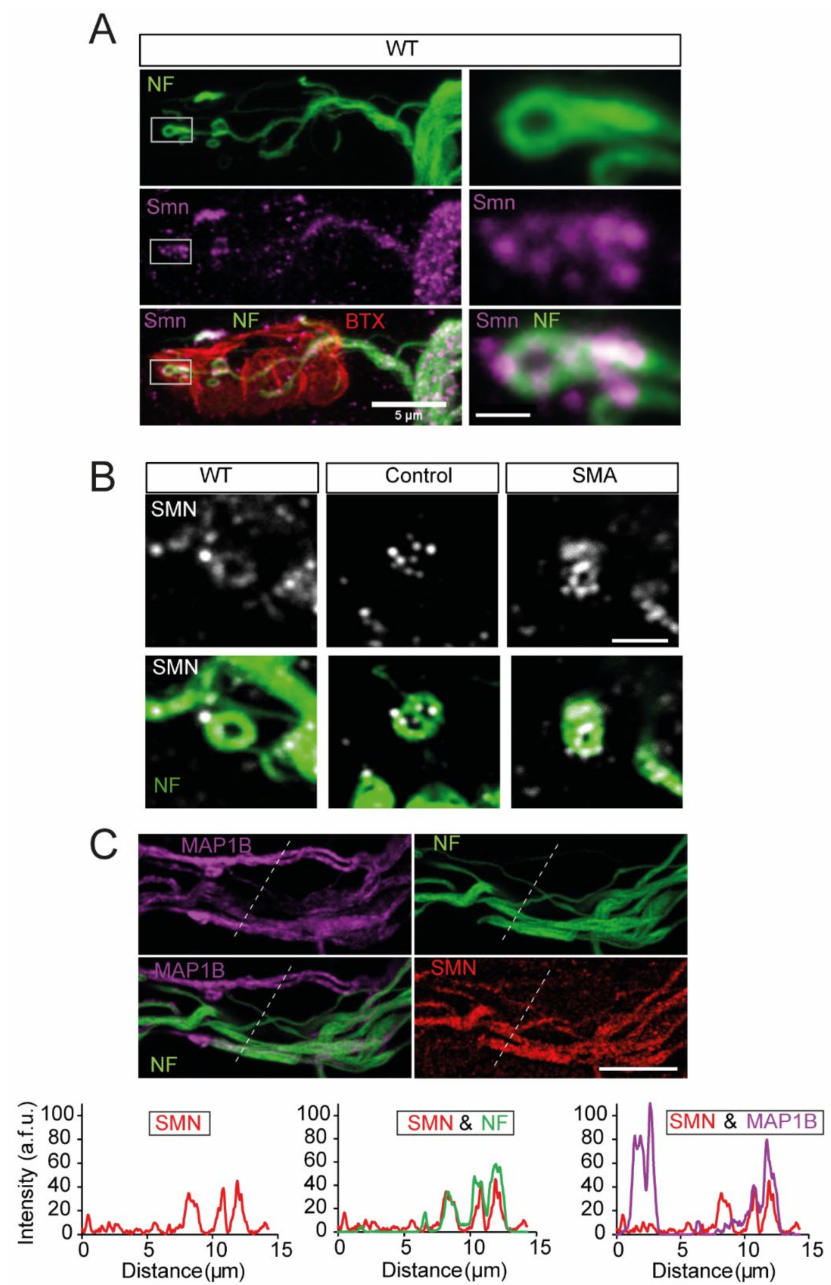
Figure 7. SMN granules co-localize with NFs in presynaptic motor terminals and axons. ( A ). Representative example showing that SMN granules (magenta) follow the NF (green) path, from the motor nerve to the distal part of the intraterminal branches, in a TVA muscle from a wild-type mouse. The endplate was labeled with BTX (red). On the right panels, the delimited regions are shown magnified. Scale bars: 5 µ m and 750 nm, respectively. ( B ). Details of SMN granules (grey), following NFs intraterminal structures (green) in wild-type and SMN ∆ 7 (control and SMA) mice. Scale bar: 2 µ m. ( C ). SMN granules show a greater degree of coincidence with the NFs than with MAP1B. Example of a band of axons from a Taiwanese control mouse labeled for MAP1B (magenta), NFs (green), and SMN (red). Note the heterogeneity of the axons, in terms of their immunoreactivity for each of these proteins. Scale bar: 10 µ m. The graphs display the intensity profiles through the lines in the images. Note the better coincidence of SMN (red trace) with axons showing a high NFs intensity (green traces) than with axons displaying a high MAP1B content (magenta traces). a.f.u., arbitrary fluorescent